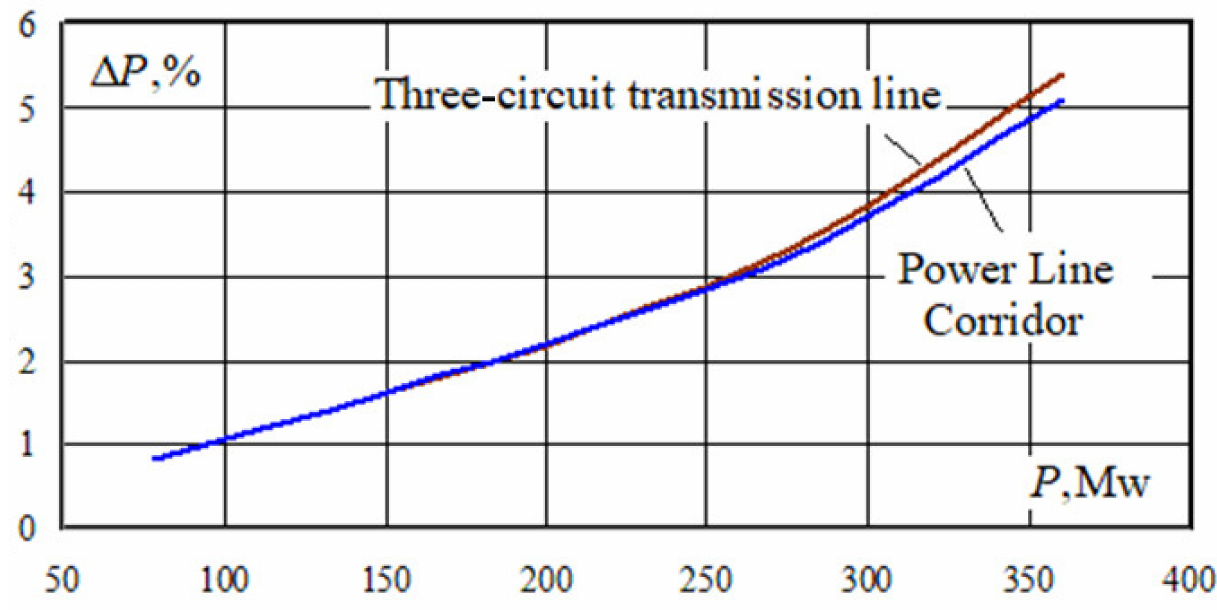
Figure 13. Losses as a function of transmitted active power.